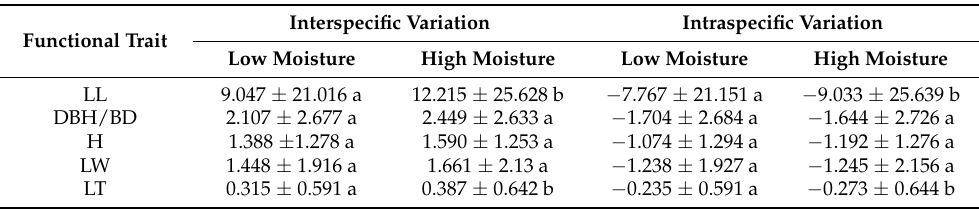
Table 3. Variation in plant functional traits among and within species under different water gradients (mean ± SD).